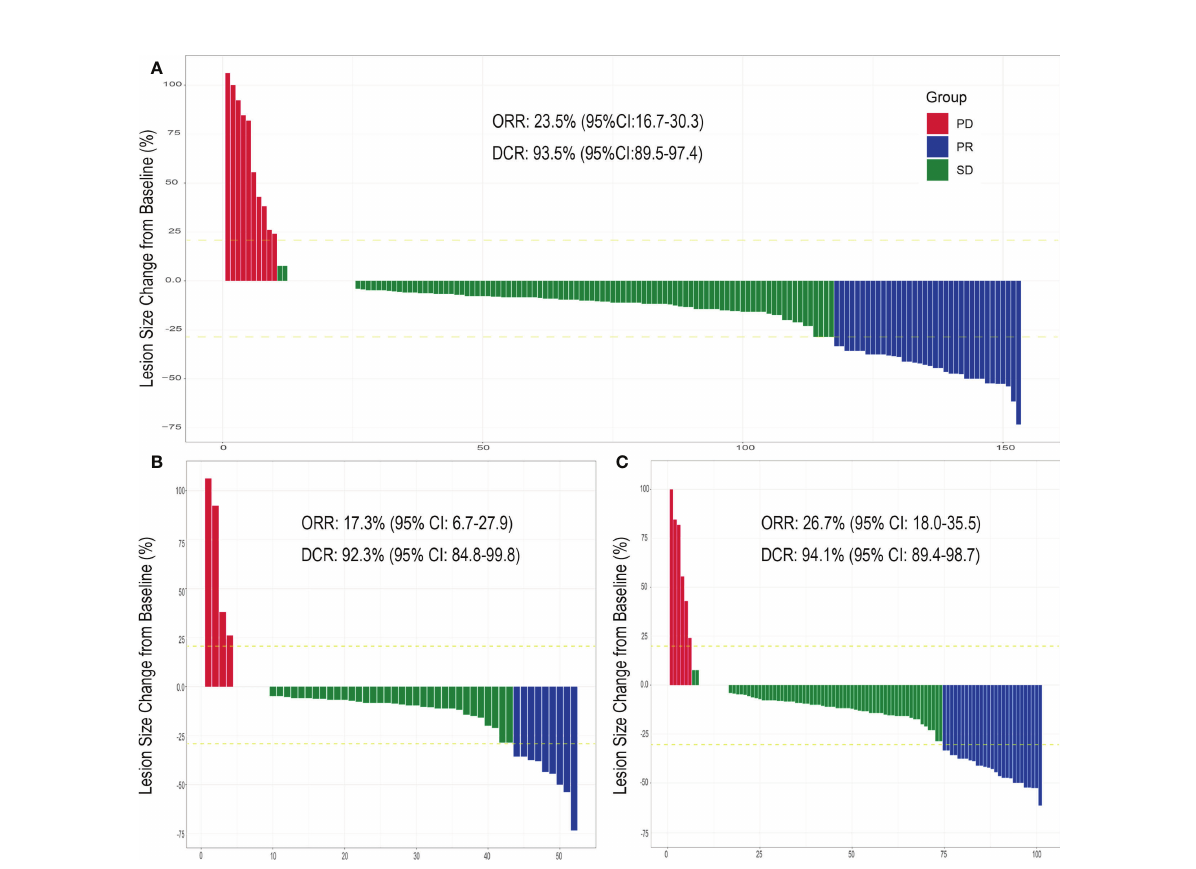
FIGURE 1 Evaluation of cervical tumor response after HIFU treatment. The index tumor size change from the baseline following HIFU treatment for (A) cervical cancer patients previously treated with CRT and experiencing residual tumors or recurrence (total) within a previously irradiated fi eld, (B) patients experiencing residual tumors and (C) patients experiencing tumor recurrence. Abbreviations: partial response (PR), stable disease (SD), progressive disease (PD), objective response rate (OR), disease control rate (DCR) and con fi dence interval